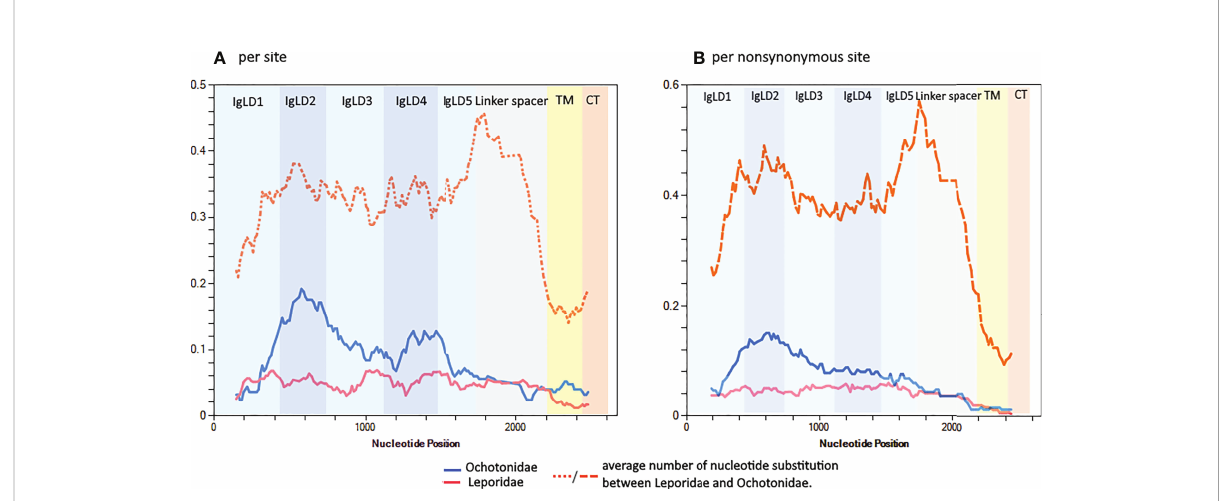
FIGURE 4 Sliding window along the pIgR nucleotide sequences showing the nucleotide diversity for Leporidae and Ochotonidae for (A) all sites and for (B) nonsynonymous sites. All Lagomorph sequences used in this study, except the Leporidae short transcripts, were used in this analysis. The analysis was performed in DnaSP version 6.12 with a window length of 250 nucleotides and a step size of 12 nucleotides. The pIgR domains are